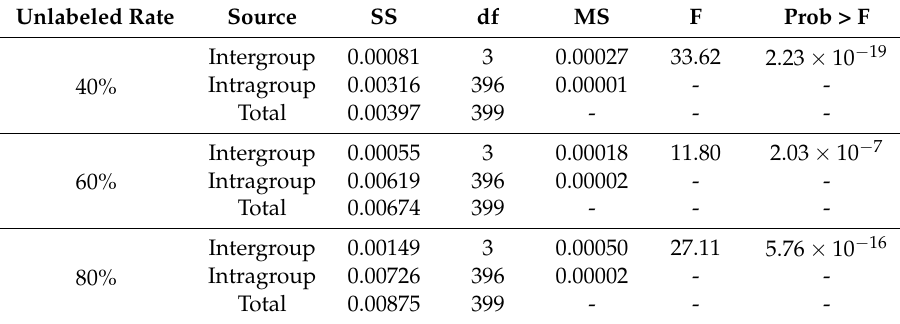
Table 7. ANOVA table under different unlabeled rates.